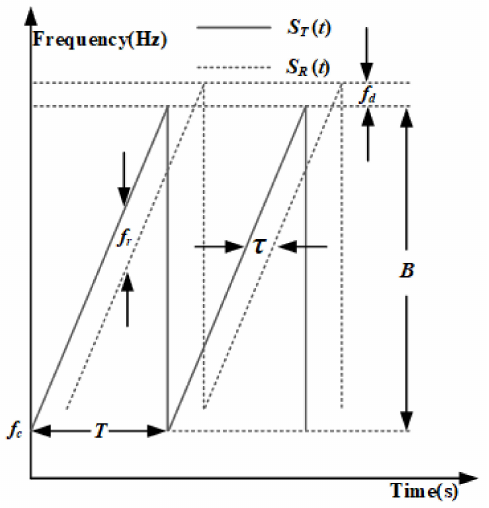
Figure 3. FMCW (frequency-modulated continuous-wave) principle of a sawtooth